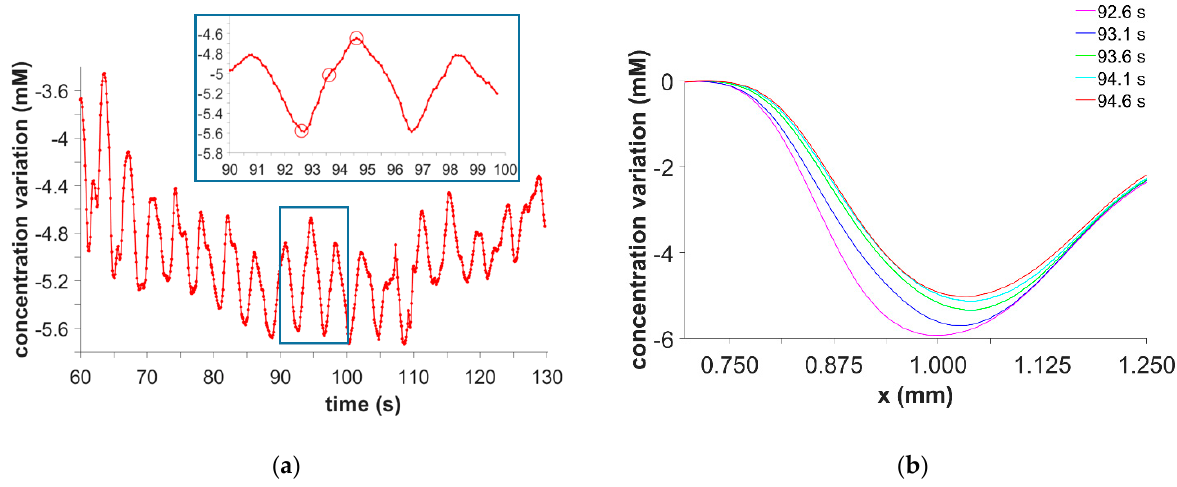
Figure 4. ( a ) Oscillations of the concentration in electroless deposition (J = 0 mA/cm 2 ) averaged in the region of interest (ROI) marked in Figure 5 (rectangle). The inset shows an expanded view of the oscillations. ( b ). Concentration variation profile along the black line marked in Figure 5.